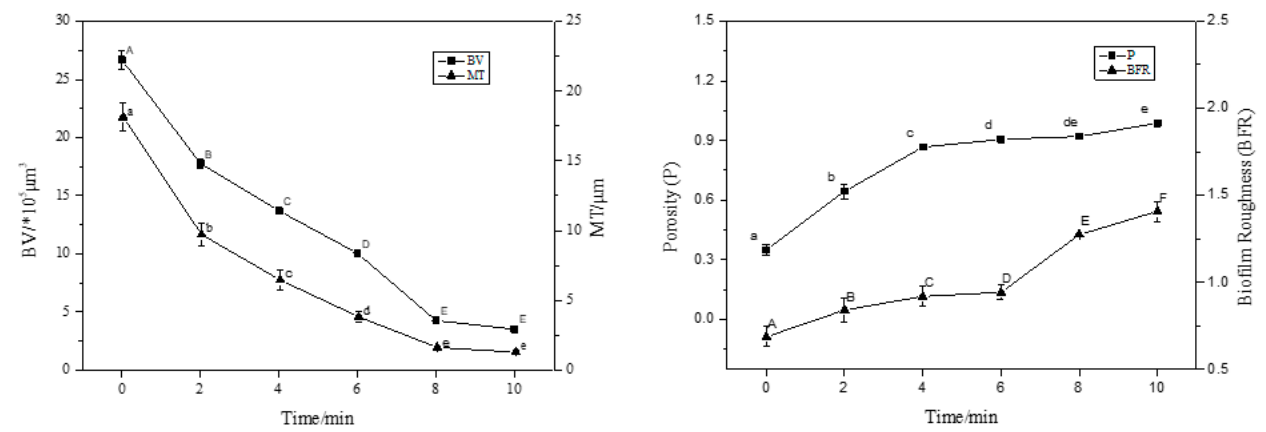
Figure 9. The CLSM images analysed by ISA-2 software to determine the biovolume (BV), mean thickness (MT), porosity (P) and biofilm roughness (BFR) of the biofilm. Data were expressed by mean measurements ± standard deviation (SD) and all treatments and determinations were performed in triplicate. The different letters indicate significant differences ( p < 0.05).